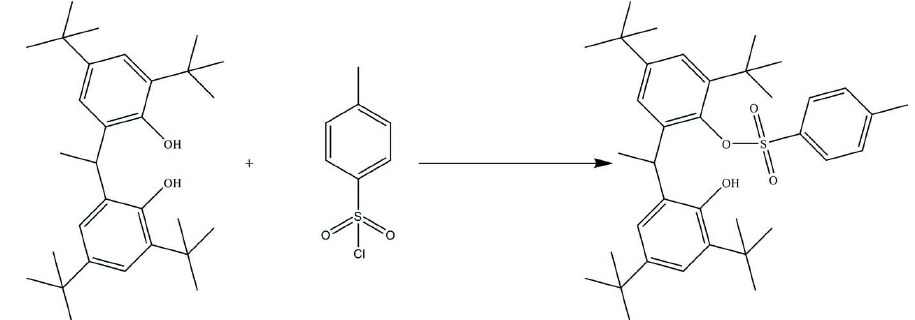
Figure 2 The formation of the title